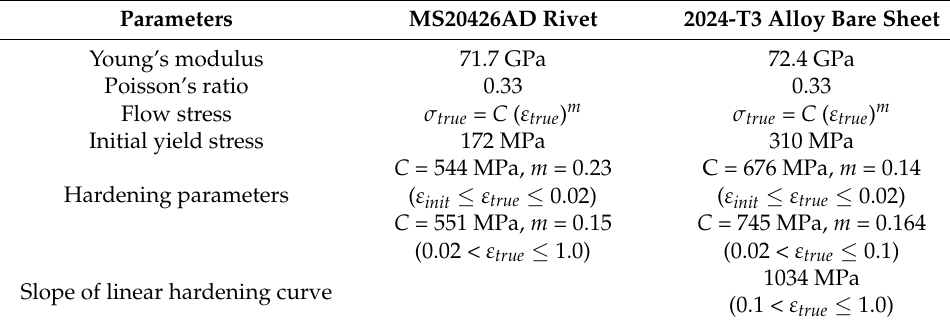
Table 1. Material properties used for the finite element analysis.